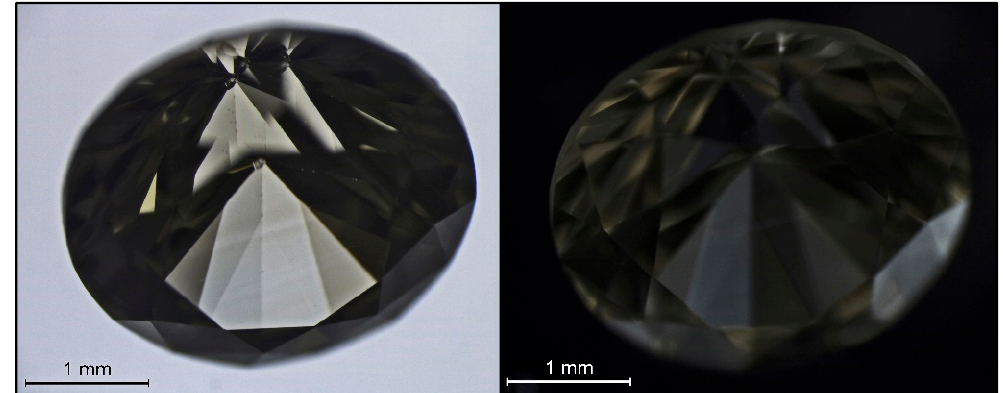
Figure 12. A hydrogen-rich light yellow-brown diamond (TH 2.618), not colored by deformation-related defects, but by nickel-nitrogen-(hydrogen?)-related defects in immersion ( left ) and under crossed polarizing filters ( right ). Very faint parallel color zoning can be seen, the strain in the diamond is virtually undetectable using crossed polarizers.